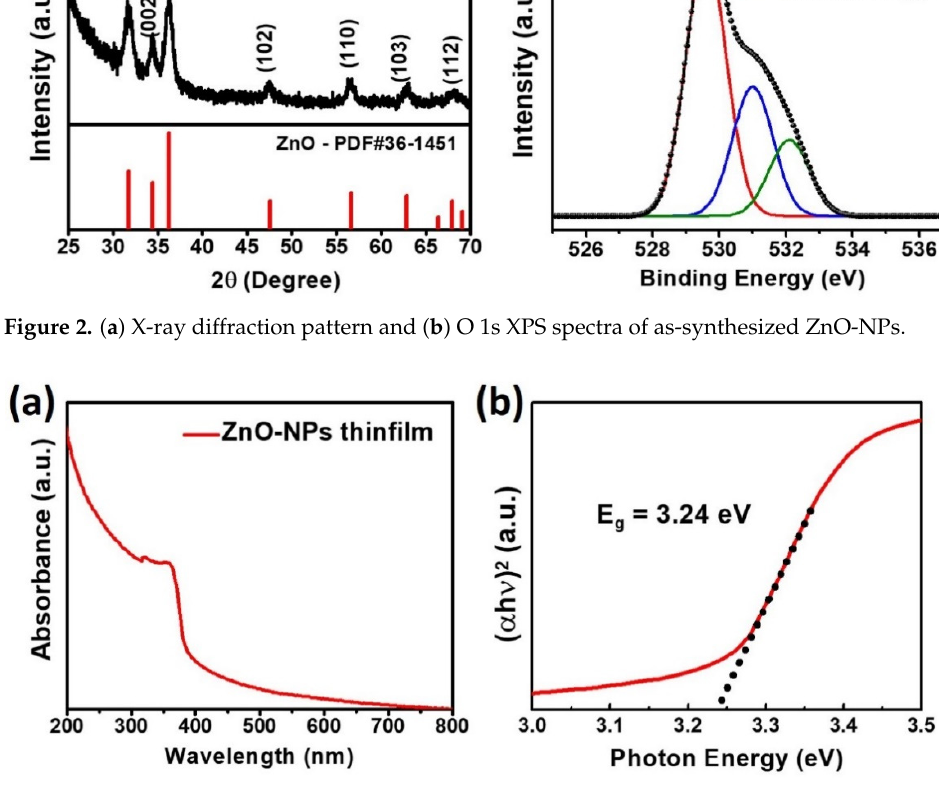
Figure 3. ( a ) Absorption spectrum and ( b ) Tauc plot of ZnO-NPs thin film.